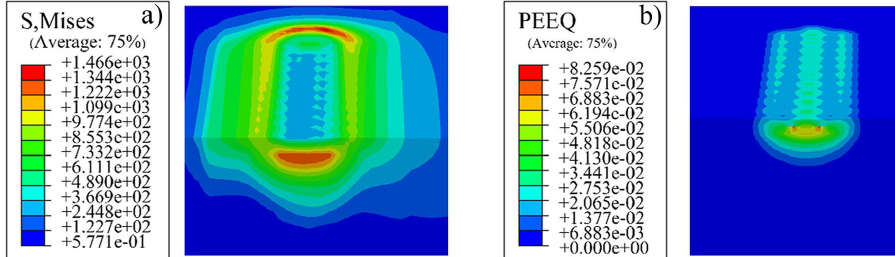
Figure 4. Miss stress cloud (a) and equivalent plastic strain diagram (b).